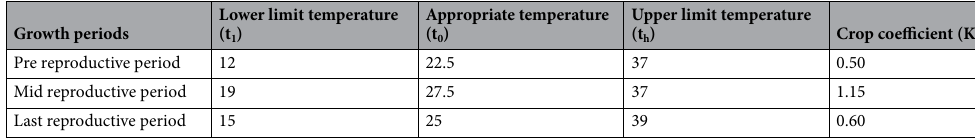
Table 2. Three fundamental points temperature and crop coefficient of peanut at each growth stage in the study area.